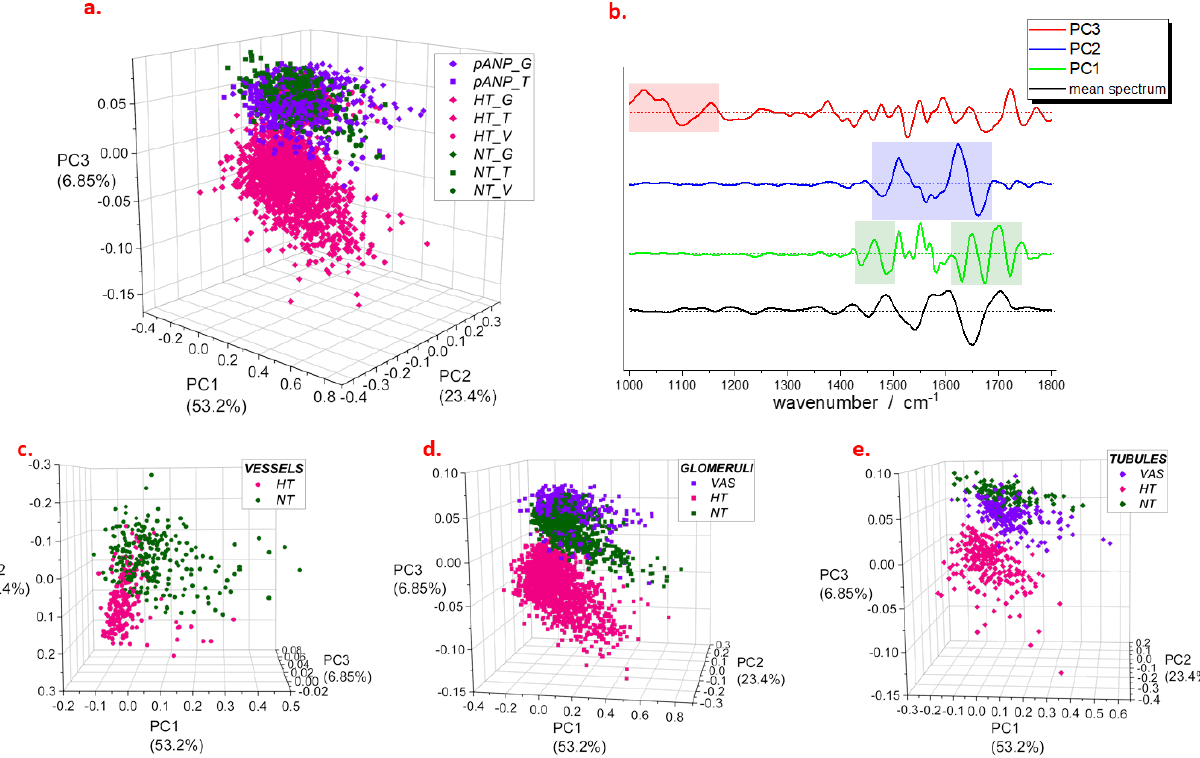
Figure 3. PCA scores ( a ) and loadings ( b ) from analysis of spectra selected on different structures of renal parenchyma. In panel ( b ), shadowed areas demonstrate the most intense contributions to the loadings; mean spectrum refers to the entire set of data; dashed lines indicate the zero intensity for each curve. Detail of scores obtained for vessels ( c ), glomeruli ( d ), and tubules ( e ). Legend: NT, normotensive; HT, hypertensive; pANP, proANP 31 – 67 -treated.